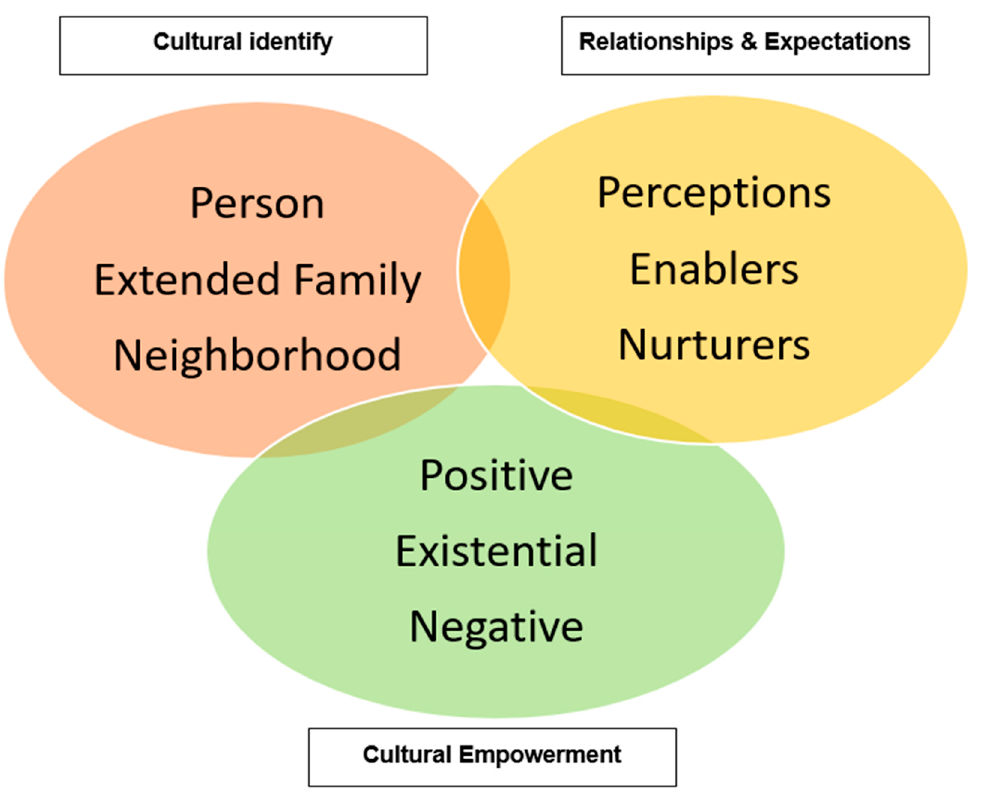
Figure 1. The PEN-3 cultural model.